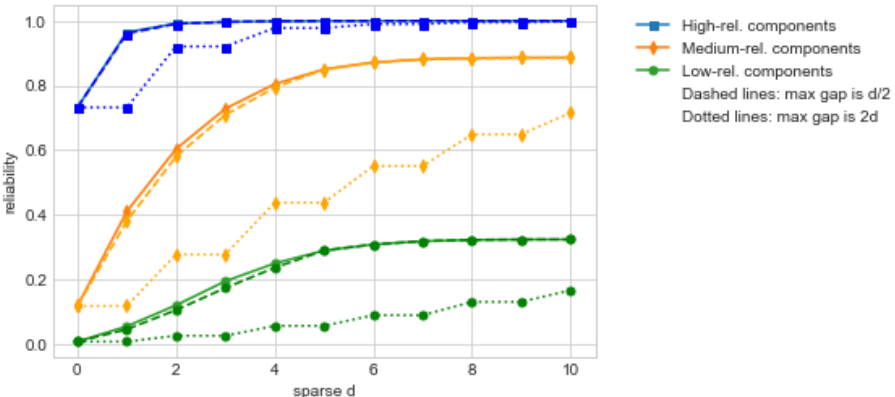
Figure 3. System reliability for consecutive 5-out-of-15 systems with sparse d = { 0, . . . ,10 } and maximum gap set as d /2 or 2 d . Systems with low, medium and high reliability